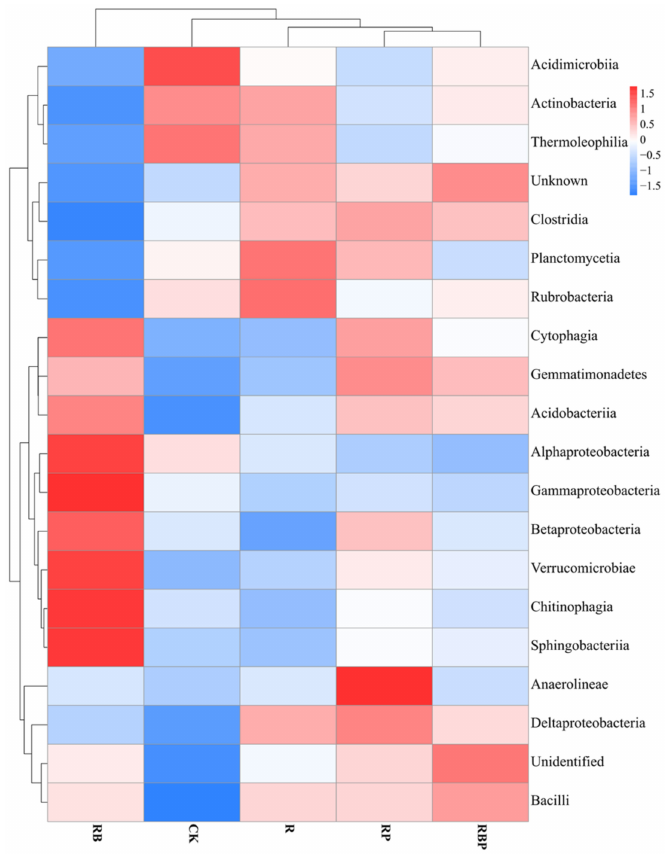
Figure 2. Cluster analysis of soil bacteria community (top 20 bacteria) at class level under different